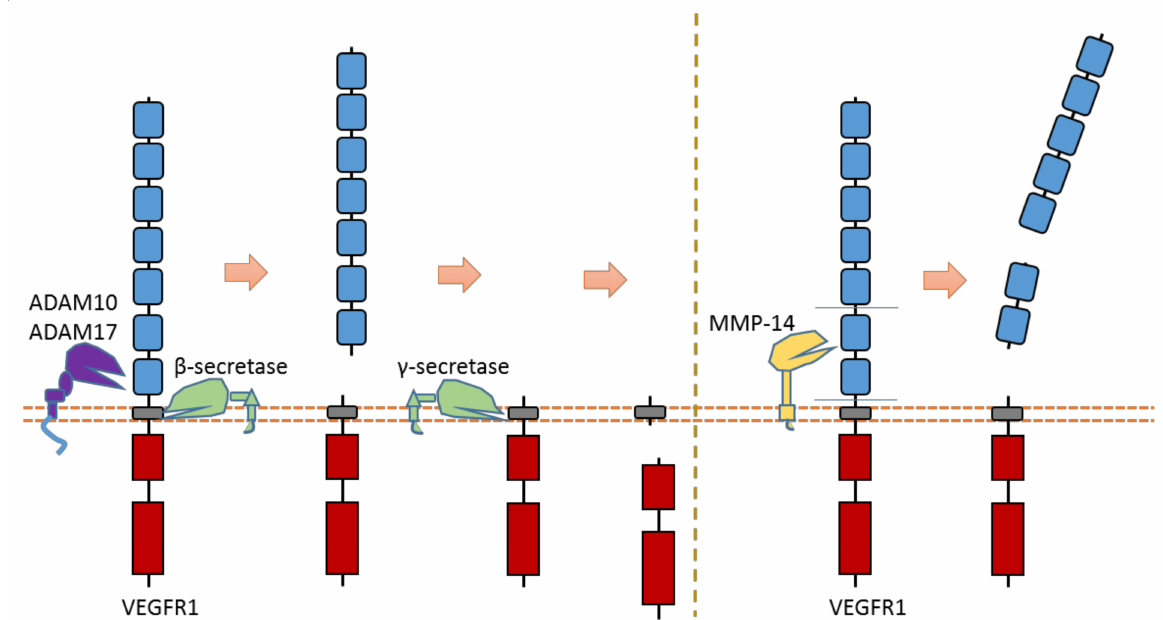
Figure 13. Schematic illustration of proteolytic cleavage in